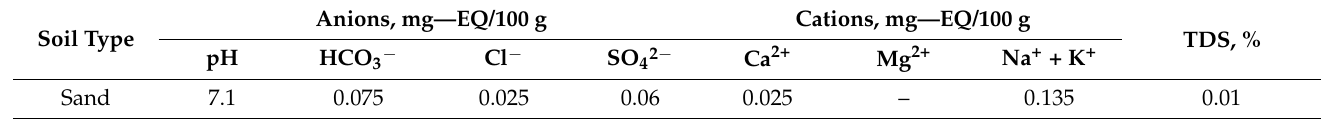
Table 2. Salinity and major-ion chemistry of solutions used in